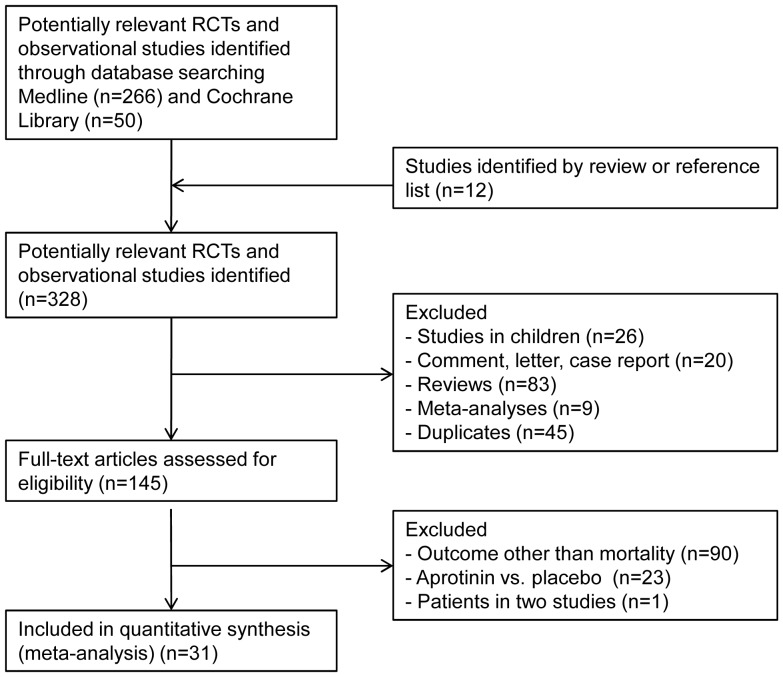
Flow of information through the different phases of the systemic review.